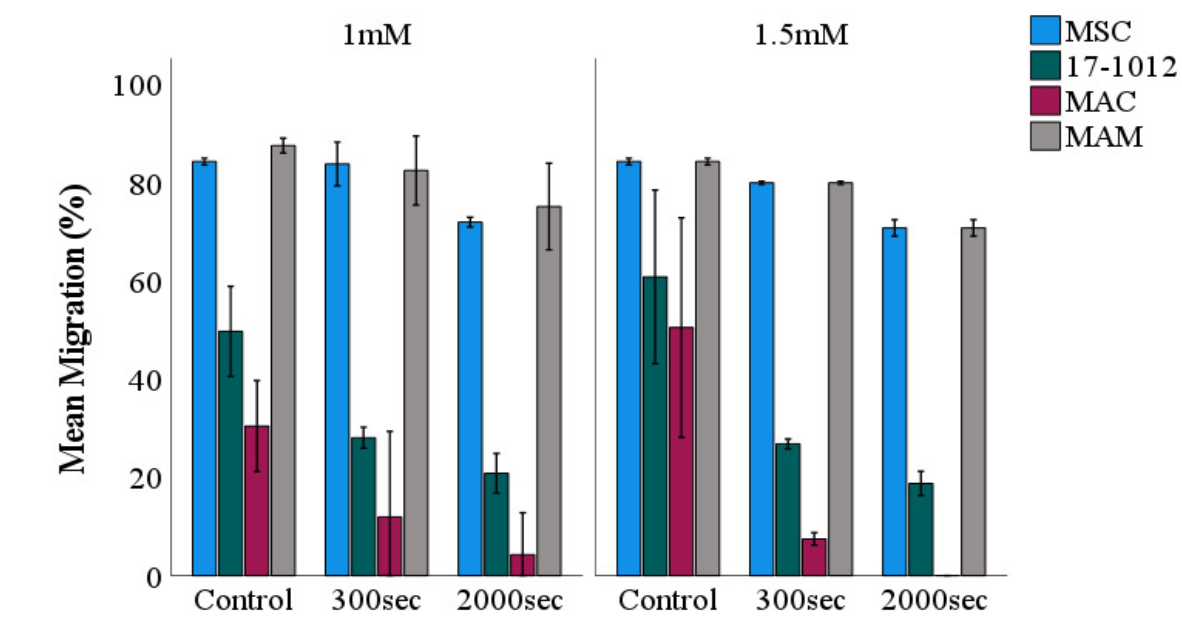
Figure 2. Semi-quantitative assessment of cellular migration potential following PDT exposure. The rate of cell migration for all cell lines (17-1012—giant cell tumor of bone, MAC—bone metastases of invasive ductal breast carcinoma, MAM—bone metastases of renal cell carcinoma and MSC) was measured as a distance ( µ m, using the open-source software ImageJ) 24 h post light exposure. As a photosensitizer, 5-ALA was employed at two different concentrations: 1 mM (left side) and 1.5 mM (right side). Values represent means ± SEM; n = 3 independent experiments. Abbreviations: 5-ALA—5-aminolaevulinic acid, sec—seconds.